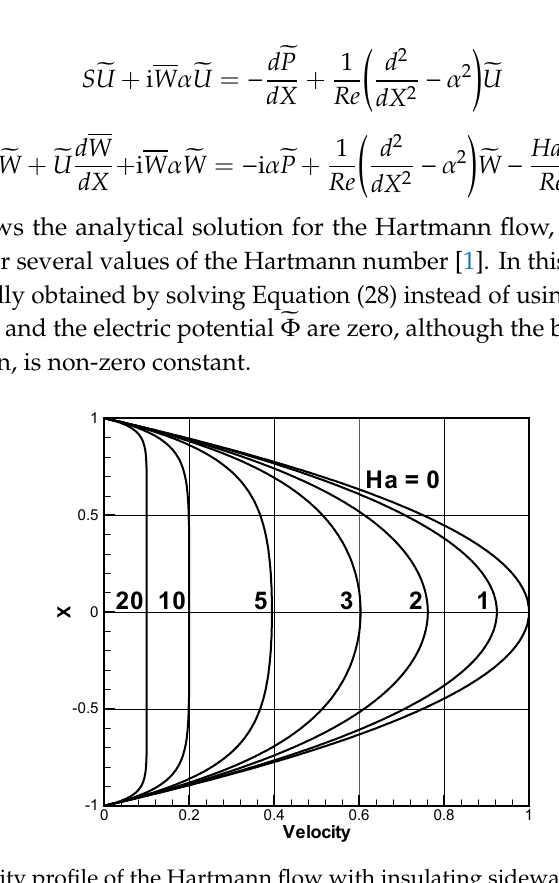
Figure 4. Basic velocity profile of the Hartmann flow with insulating sidewalls for several values of Hartmann number.